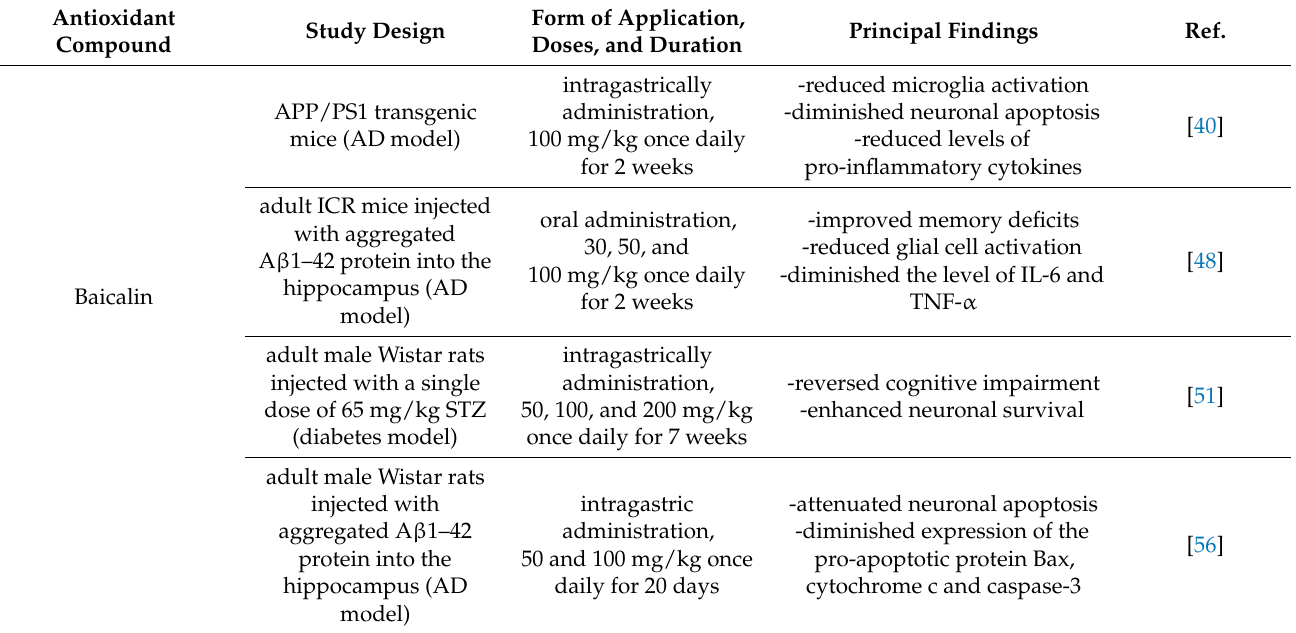
Principal Findings